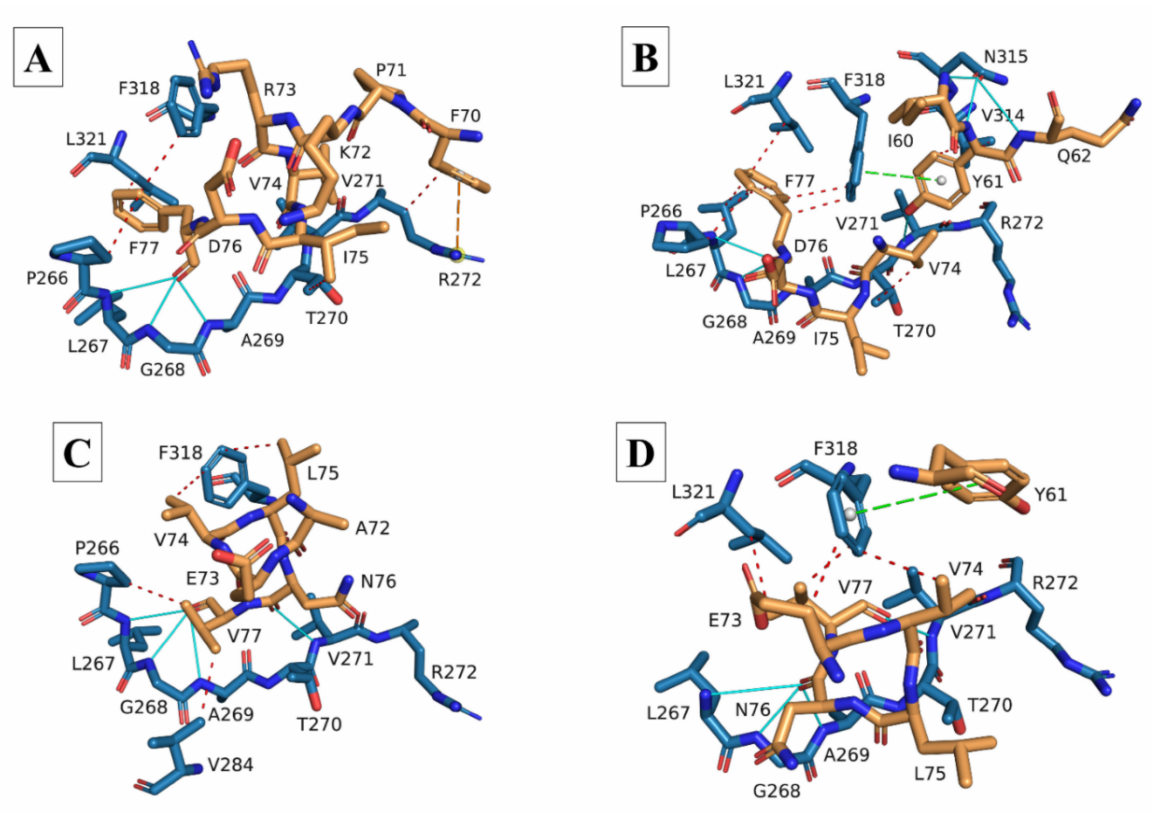
Figure 5. Stick models of the modelled 8-mer and 18-mer envelope (E) peptides of the less virulent HCoV-229E and HCoV-NL63 E proteins docked to the PALS1 PDZ domain. ( A ) Stick model of the modelled HCoV-229E (8-mer) E peptide (gold) docked to the PDZ domain of the PALS1 protein (blue). ( B ) Stick model of the modelled HCoV-229E (18-mer) E peptide (gold) docked to the PDZ domain of the PALS1 protein (blue). ( C ) Stick model of the modelled HCoV-NL63 (8-mer) E peptide (gold) docked to the PDZ domain of the PALS1 protein (blue). ( D ) Stick model of the modelled HCoV-NL63 (18-mer) E peptide (gold) docked to the PDZ domain of the PALS1 protein (blue). Peptides in ( A – D ) were produced from the homology-modelled E proteins of the respective hCoVs and docked to the partial PALS1 protein (PDB ID: 7NTK) using the HADDOCK webserver. Docked E peptides with the lowest RMSD values compared to the 7NTK experimental E peptide were uploaded to the protein– ligand interaction profiler (PLiP) webserver to demonstrate the types of interactions between PALS1 and the E peptides. Red, dashed lines: hydrophobic interactions; Cyan, solid lines: hydrogen bonds; Yellow, dashed lines: ionic interactions (salt bridges); Green, dashed lines: cation- π